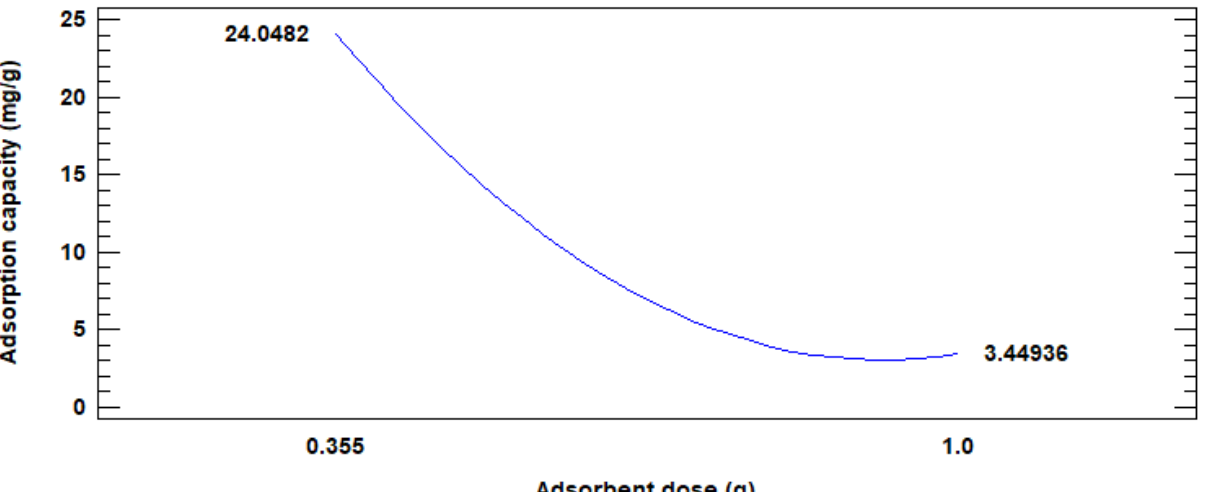
Figure 4. Main effect plot of the adsorbent dose on the adsorption capacity of Cr (VI). A wide range of initial Cr(VI) concentrations were selected from 31.82 to 368 mg/L